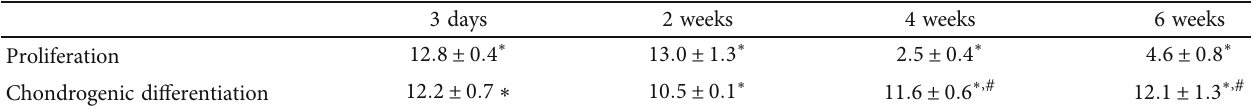
Table 2: Cell density (cells/mm 2 ) of hDPSC microtissues cultured with proliferation or chondrogenic di ff erentiation media for 3 days and 2, 4, and 6 weeks. Samples at initial time ( t = 0 ; cell density: 9,400 ± 600 ) were taken as control. Values shown ( mean ± SD ) are × 10 3 . Statistical signi fi cance at p ≤ 0 : 05 with respect to control ( ∗ ) and to samples cultured with proliferation medium for the same period of time ( # ).